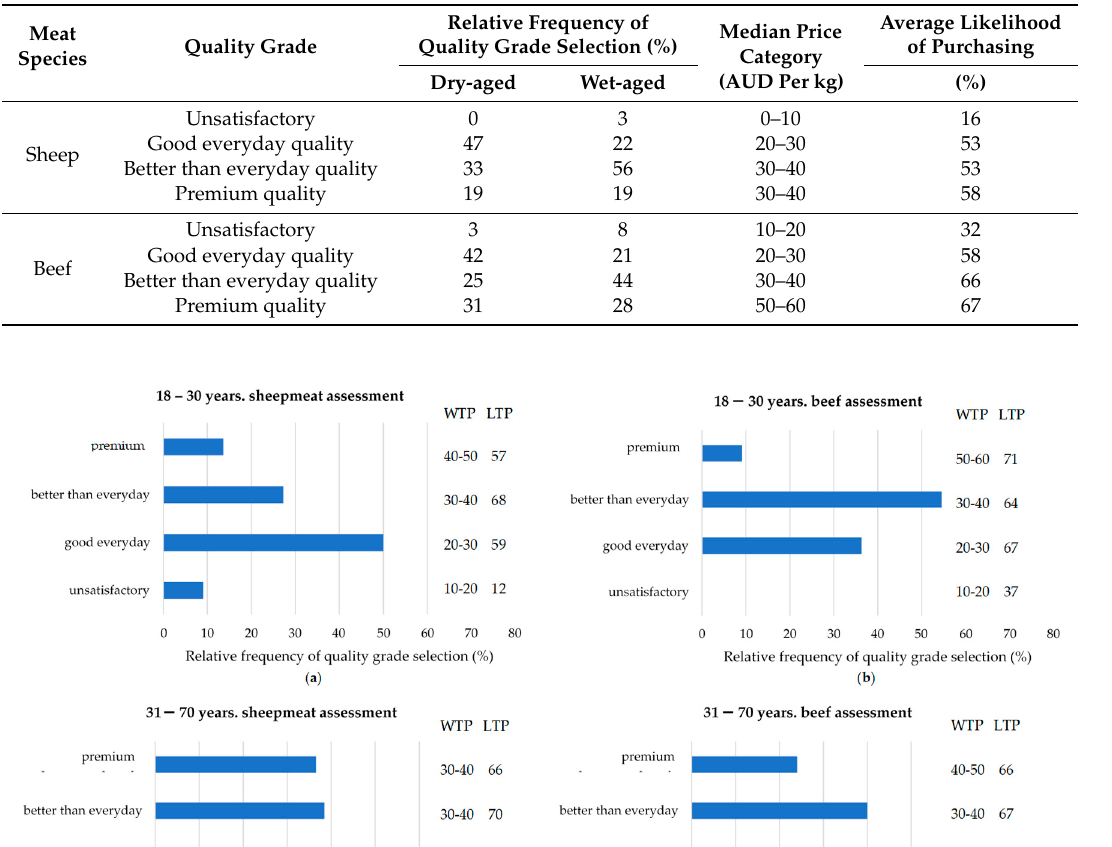
Table 4. Frequency of selecting a quality grade (“unsatisfactory”, “good everyday quality”, “better than everyday quality”, or “premium quality”) within each meat species (sheep or beef) according to ageing method (wet or dry) and associated willingness to pay data, indicated by median price category (0–10, 10–20, 20–20, 30–40, 40–50, 50–60 or 60–70, Australian dolllars (AUD) per kg) and the average likelihood of purchasing.